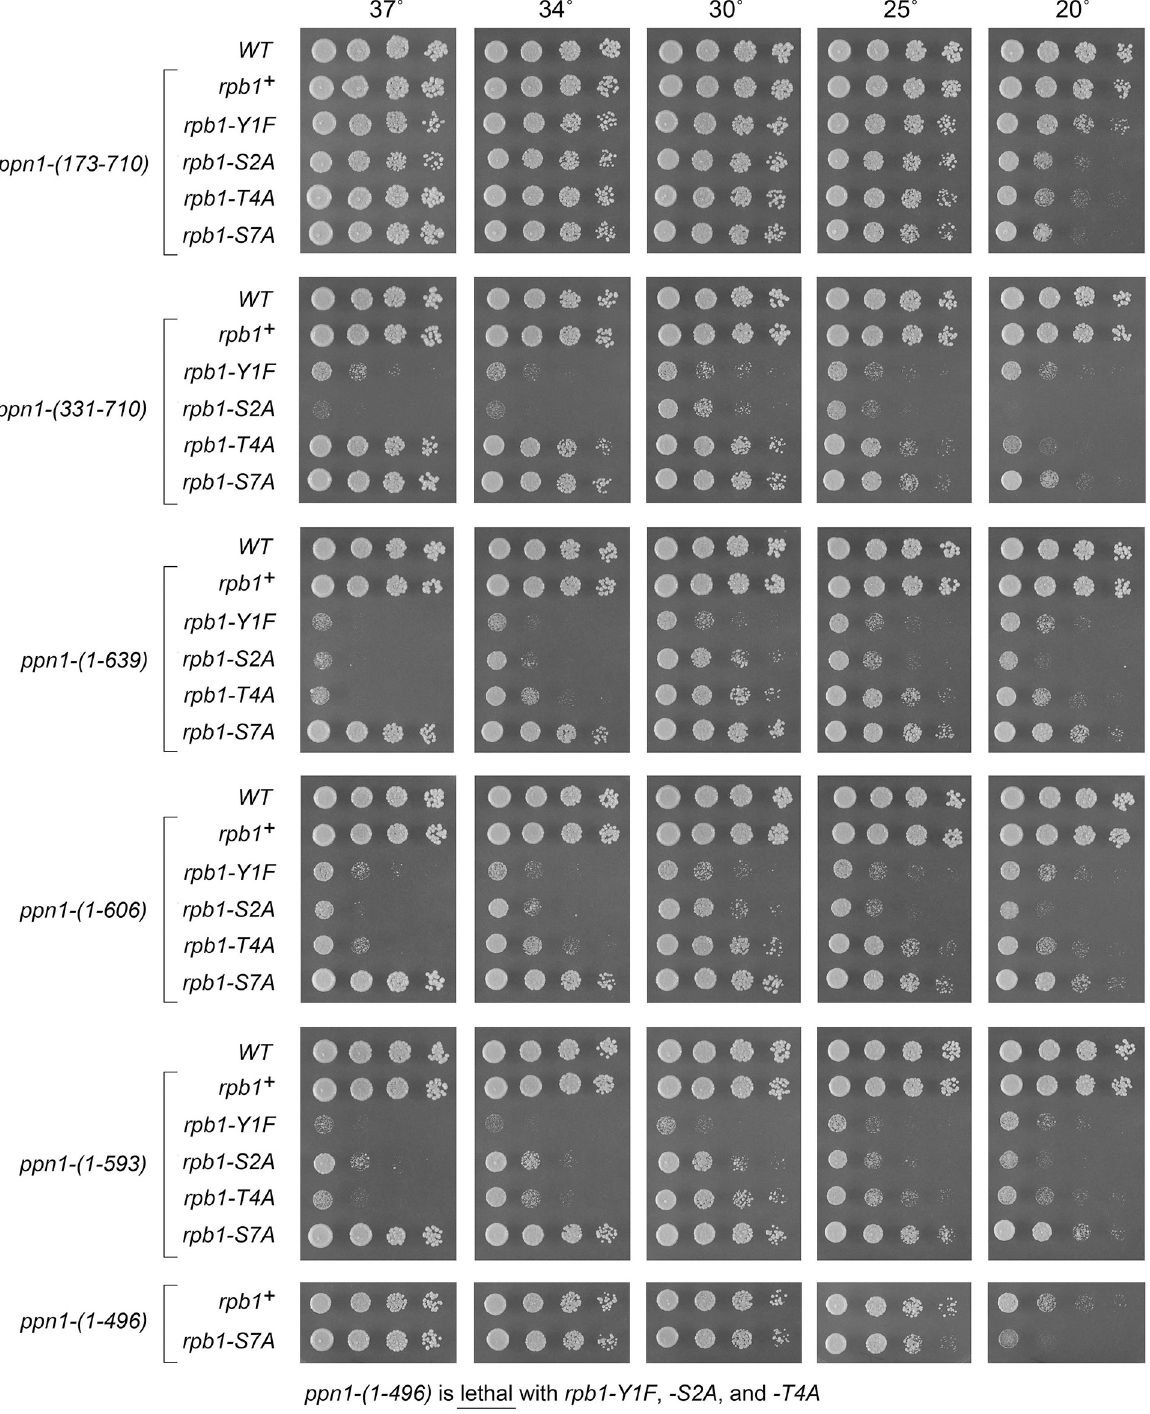
PLOS Genetics | https://doi.org/10.1371/journal.pgen.1009452 March 12,